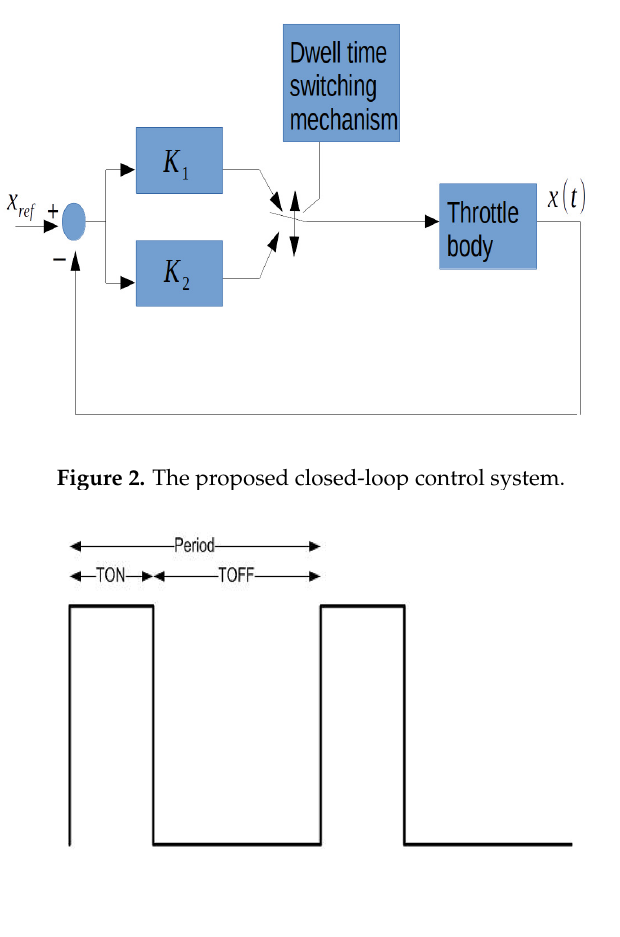
Figure 3. A dwell-switching signal which can be viewed as a pulse-width modulation (PWM)